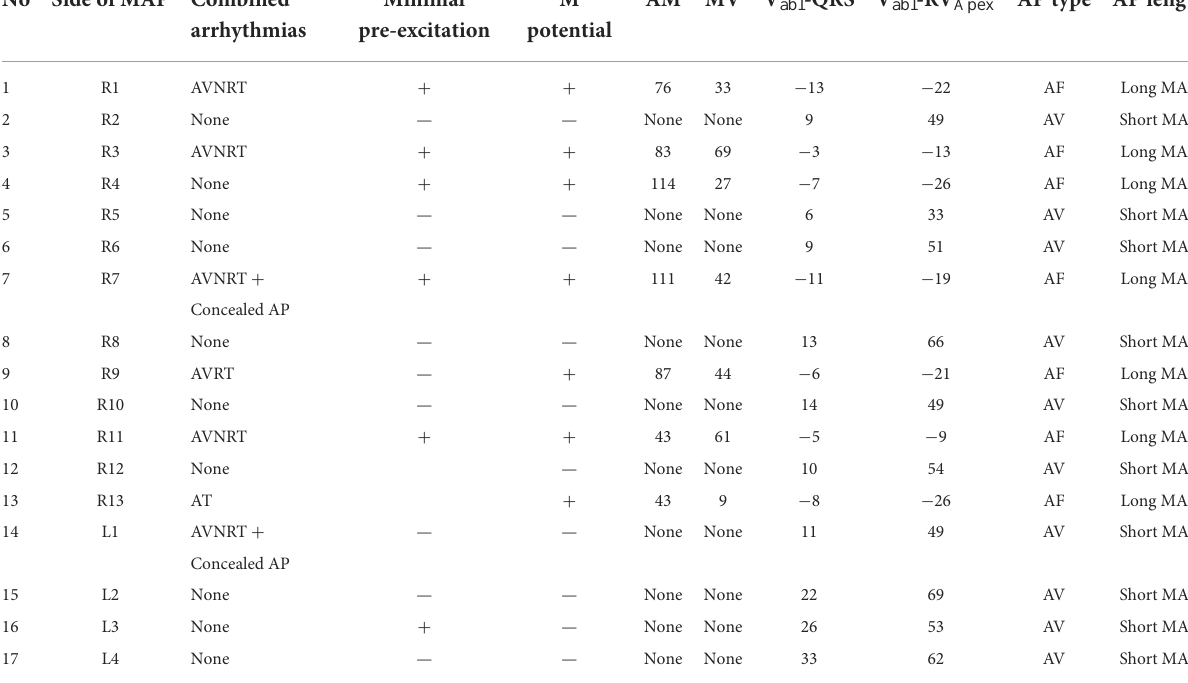
TABLE 3 EPS of all patients. No Side of MAP